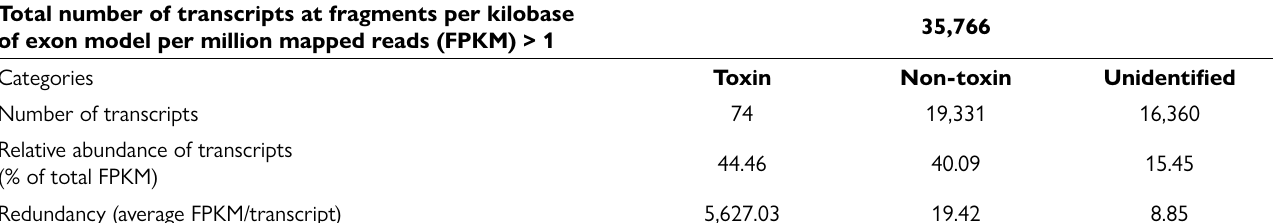
Table 1. Overview of transcript classification and expression in de novo venom gland transcriptome of C. bivirgata flaviceps . Total number of transcripts at fragments per kilobase